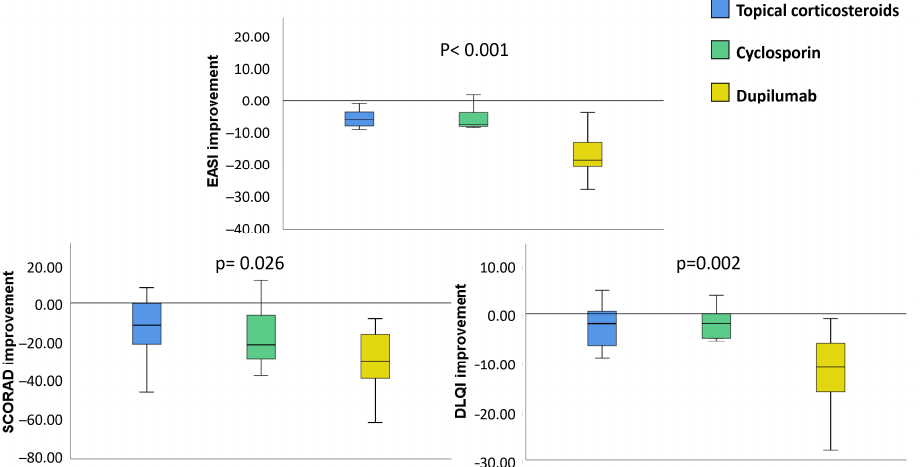
Figure 2. Differences in the improvement in clinical scores by treatment. DLQI, Dermatology Life Quality Index; EASI, Eczema Area Severity Index; SCORAD, SCORing Atopic Dermatitis. p -value after using one-way independent ANOVA test to compare changes in scores between different treatments (topical corticosteroids, cyclosporine and dupilumab).